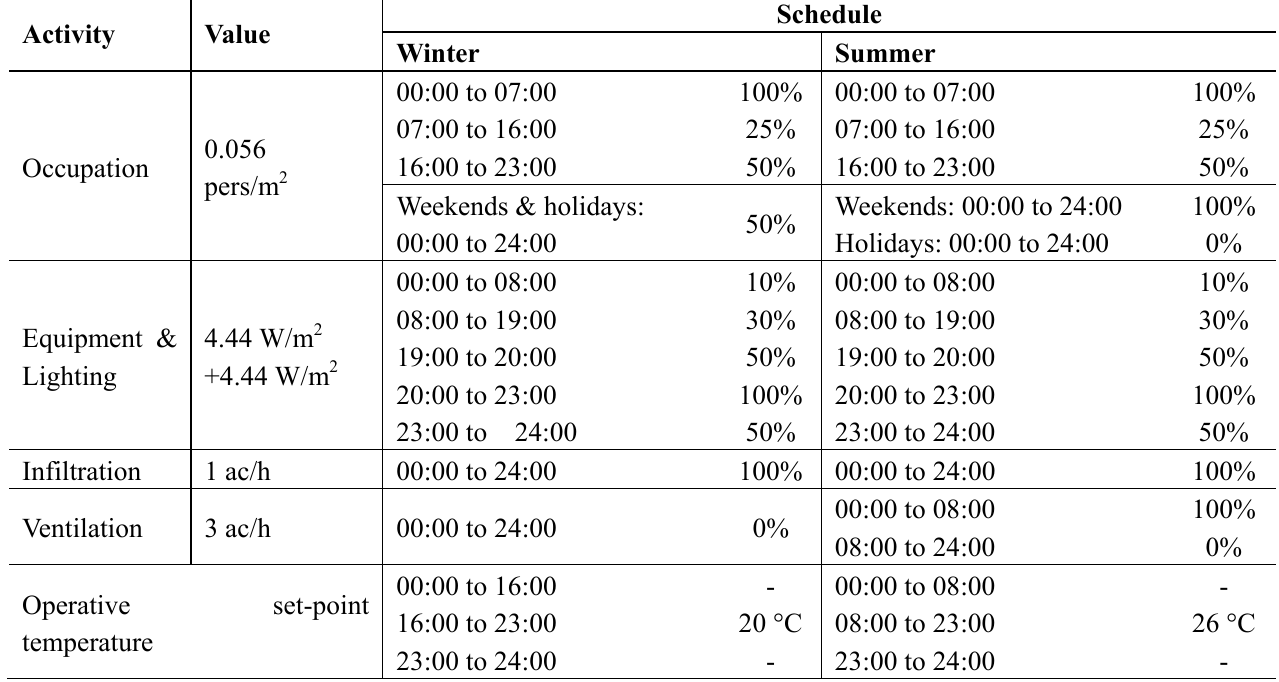
Table A2. Protocols used for the demand